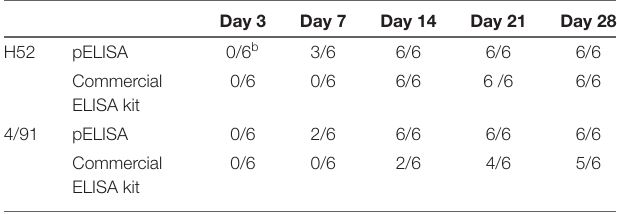
TABLE 3 | Comparison of pELISA and a commercial ELISA kit in detecting IBV antibody response in chickens a